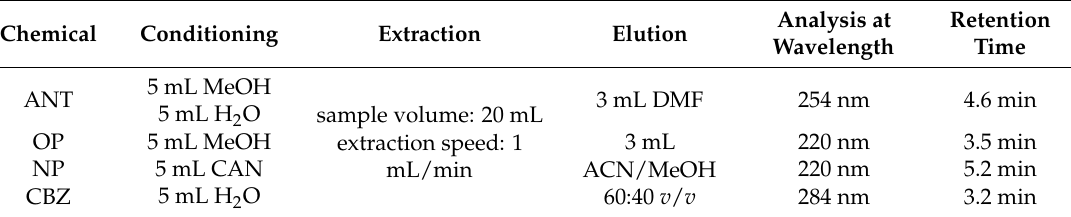
Table 4. Solid phase extraction (SPE) and chromatographic analysis conditions.